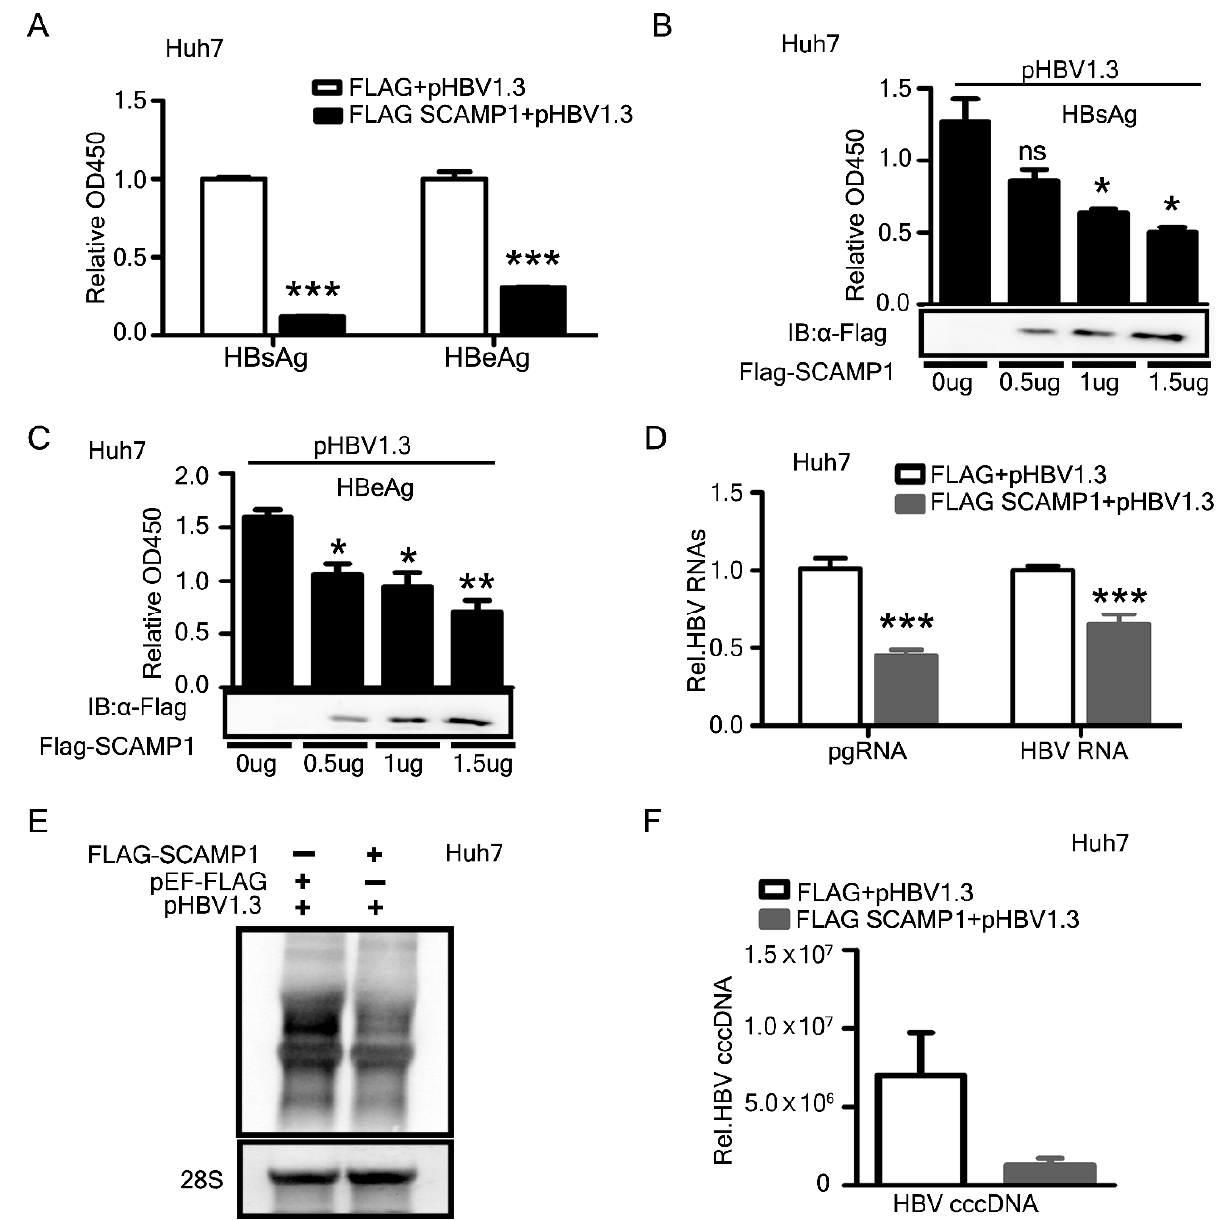
Figure 6. Overexpression of SCAMP1 inhibits HBV replication. Huh7 cells were transfected as indicated below and harvested 48 h after transfection ( A – F ). ( A ) ELISA determined the secreted HBsAg and HBeAg levels from the cell culture supernatants co-transfected (1:1) with pHBV1.3, FLAG-SCAMP1, and pEF-FLAG, are shown. ( B – D ) ELISA analysis of the secreted HBs Ag ( B ) and HBeAg ( C ) and Real-time PCR analysis of HBV RNAs or pgRNA ( D ) in Huh7 cells, transfected with pHBV1.3, together with pEF-FLAG or FLAG-SCAMP1, or an increased dose of FLAG-SCAMP1, are shown. ( E , F ) Northern blot analysis of HBV transcripts ( E ) qPCR analysis of HBV cccDNA ( F ) in Huh7 cells, transfected (1:1) with pHBV1.3, together with pEF-FLAG or FLAG-SCAMP1, are shown, (0.01 * p < 0.05; 0.001 < ** p < 0.01; *** p < 0.001 and ns, not significant).